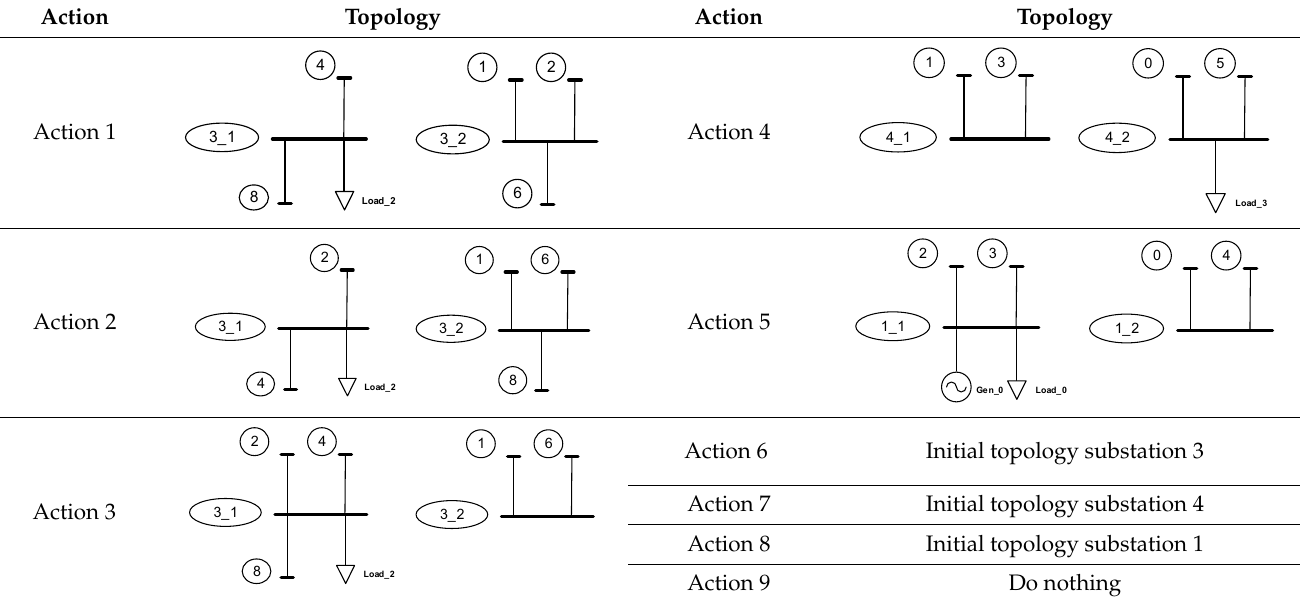
Table 3. Selected action space and topologies.